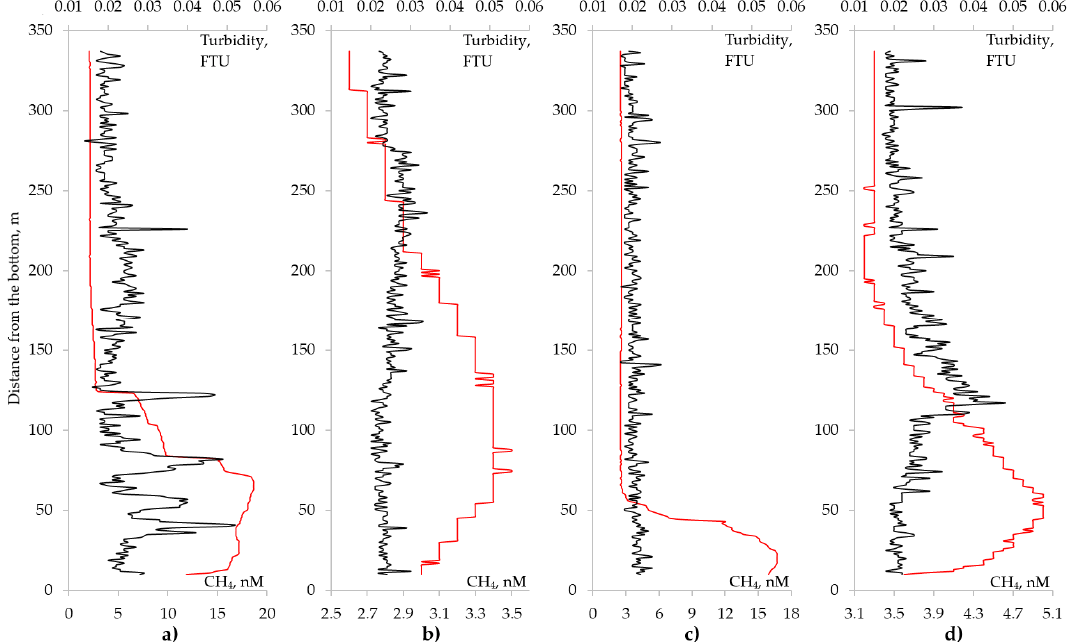
Figure 13. Change in the concentration of dissolved methane (red) and turbidity (black) with depth: ( a ) 50 m to the NW from the Irina-I vent (Logachev field); ( b ) 160 m to the NW from the Molodezhnoye field; ( c ) 190 m to the NNE from the Koralovoye field; ( d ) 200 m to the SE from the Koralovoye field.